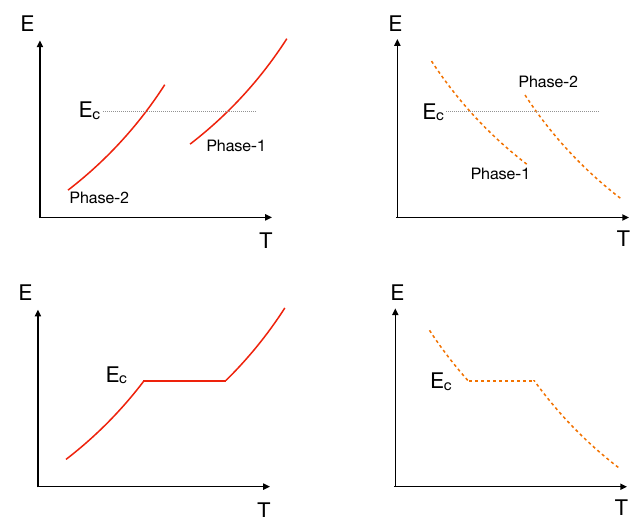
( E ) > S ( E ) at E > E 1 2 c